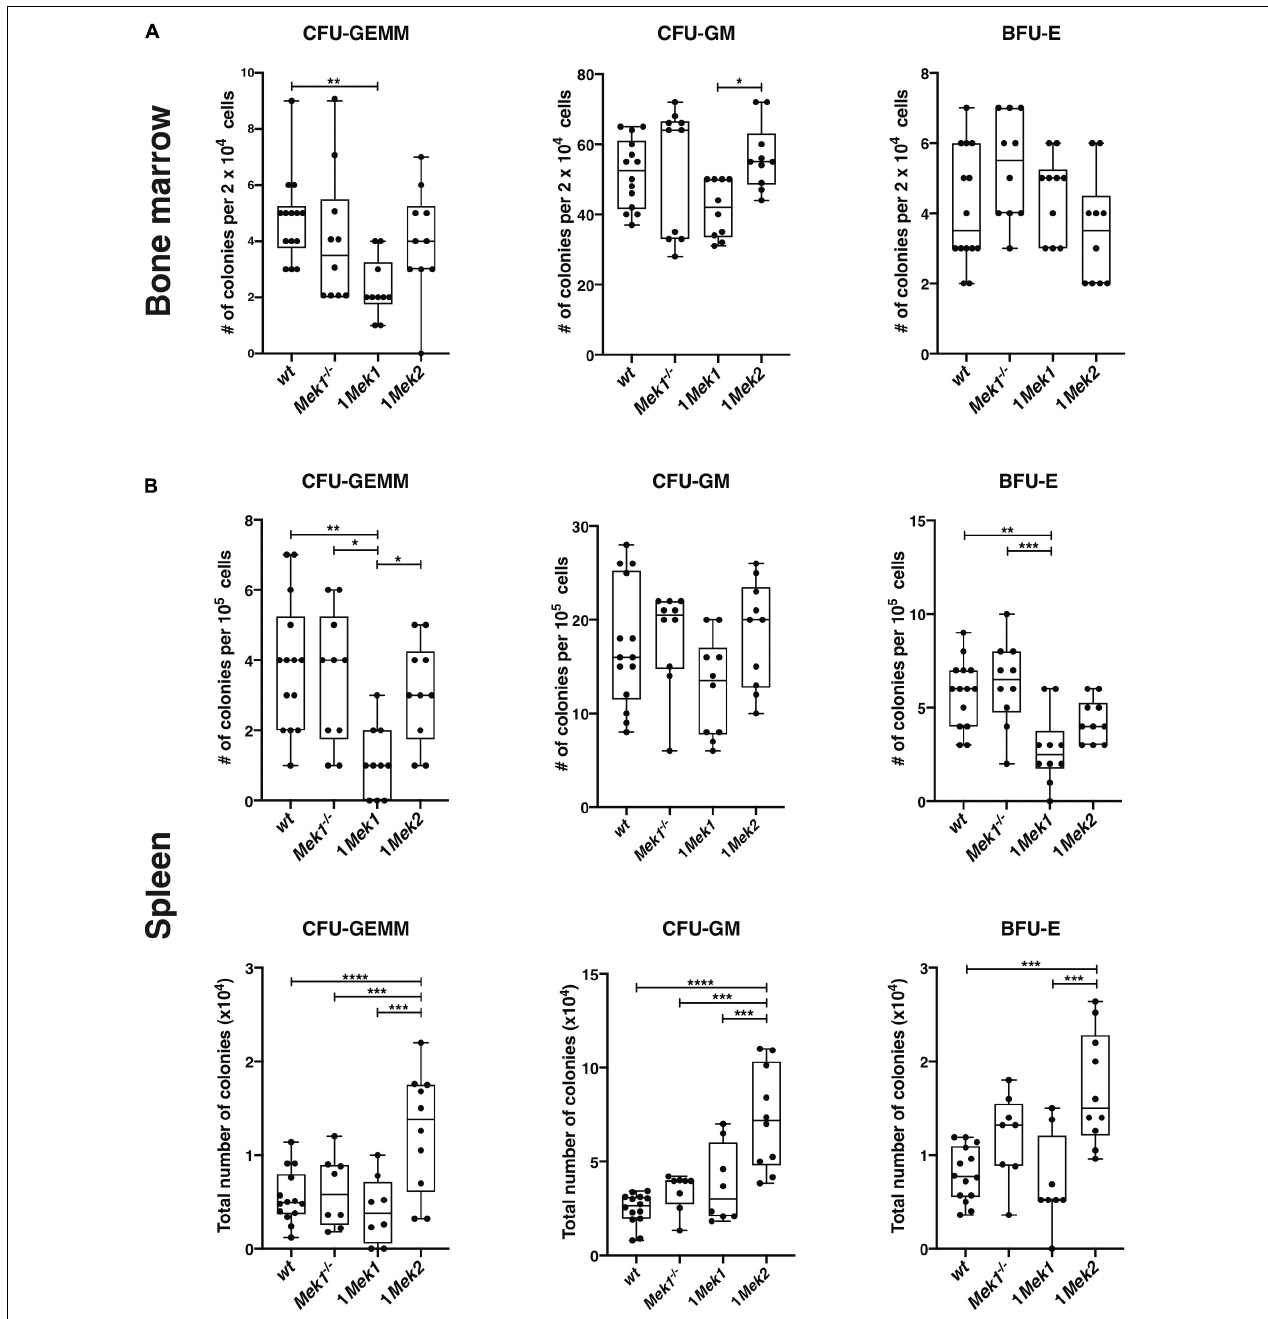
FIGURE 6 | Counts of hematopoietic progenitors in bone marrow and spleen from 1 Mek1 and 1 Mek2 mutants. CFU-GEMM, CFU-GM, and BFU-E from wt and Mek mutant bone marrow (A) and spleen (B) were measured after 7 days in methylcellulose with cytokines. A decrease in the CFU-GEMM and CFU-GM populations was observed in bone marrow of 1 Mek1 mutants, whereas an increase in the total number of progenitor populations was detected in spleen from 1 Mek2 mutants. The results are presented as whiskers-and-boxes graph, and each dot represents an individual mouse. ANOVA with Kruskal–Wallis multiple-comparisons test was performed. * P < 0.05, ** P < 0.01, *** P < 0.001, **** P < 0.0001.